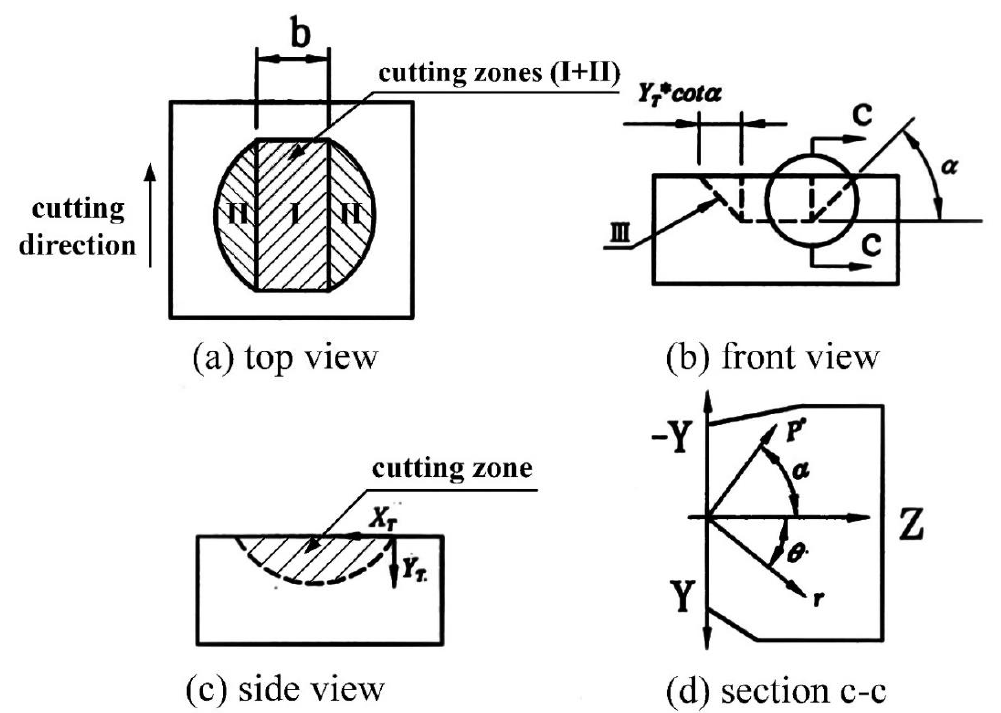
Figure 2. Wire-saw machining of Al 2 O 3 using SiC (working load of 1.27 N, wire speed of 2.8 m/s): ( a ) plastic deformation at position A and brittle fracture at position B; ( b ) debris at position D; ( c ) energy- dispersive spectrometry results for the debris shown in Figure 2b.